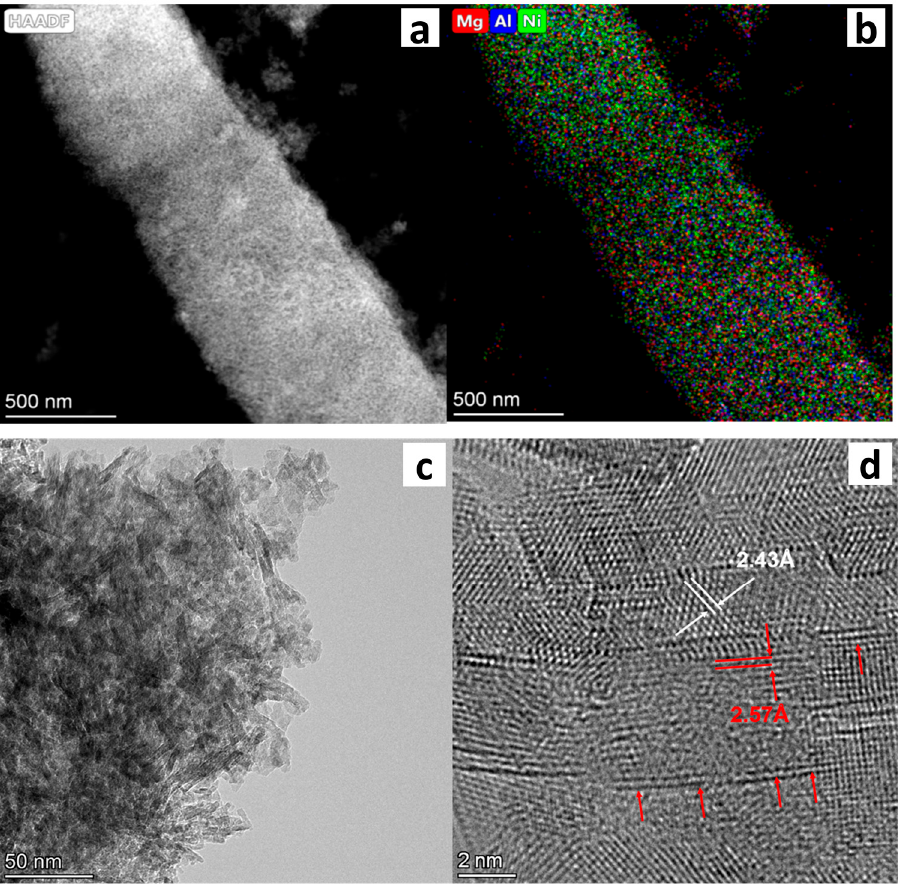
Figure 2. HAADF STEM ( a ), EDX elemental mapping ( b ) and HRTEM images ( c , d ) of Ni 1.6 Mg 3.4 Al 2 ‐ HT calcined at 600 ° С .